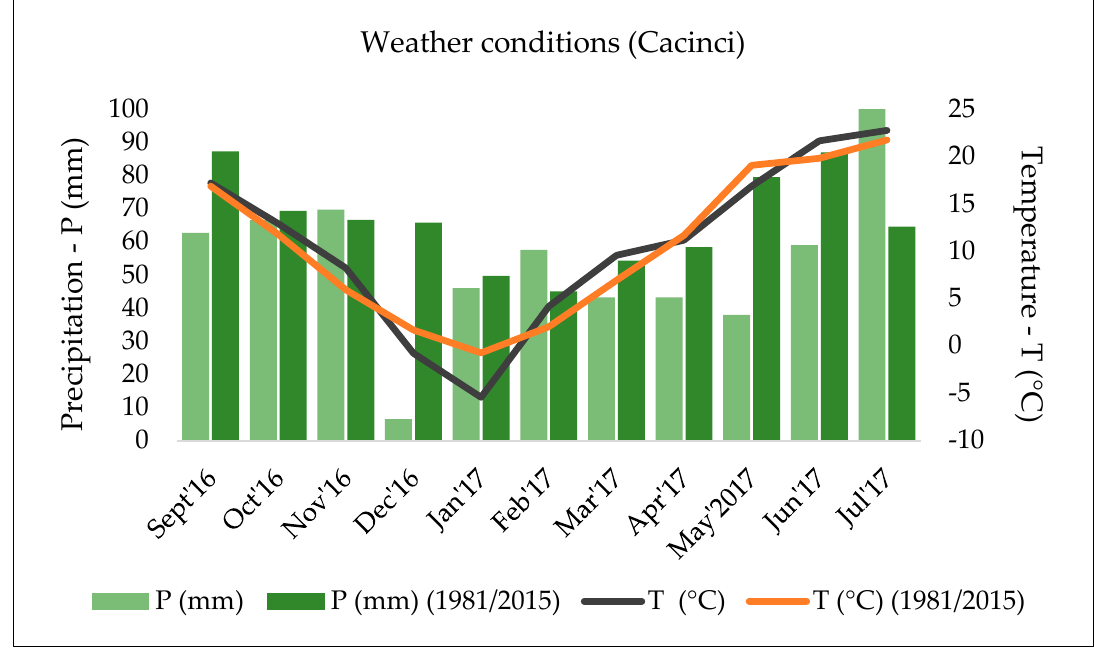
Figure 1. Average temperature and precipitation in winter wheat vegetation (September 2016–July 2017) and long-term average (1981/2015) for the Cacinci experimental site.